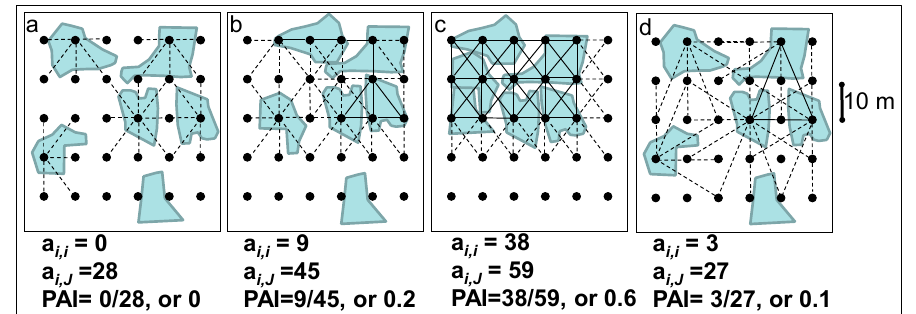
Figure 3. ( a – c ). Examples of the calculation of PAI (Point Aggregation Index) for the 0–10.5 m separation distance class in a small study area and an artificial network of sample points. ( d ) Example of PAI calculation at a different scale (the 20–25 m separation distance class). The black dots are sample plots; the blue polygons represent patches of class i, e.g., forest; and the white background represents the other landscape classes. Solid lines represent adjacencies between class i and itself, and the dashed lines show the same for class i and the other landscape class ( J ). Adjacency, in this example, is defined as plots being within the separation distance class. The equation used for calculations is given in Table 1.